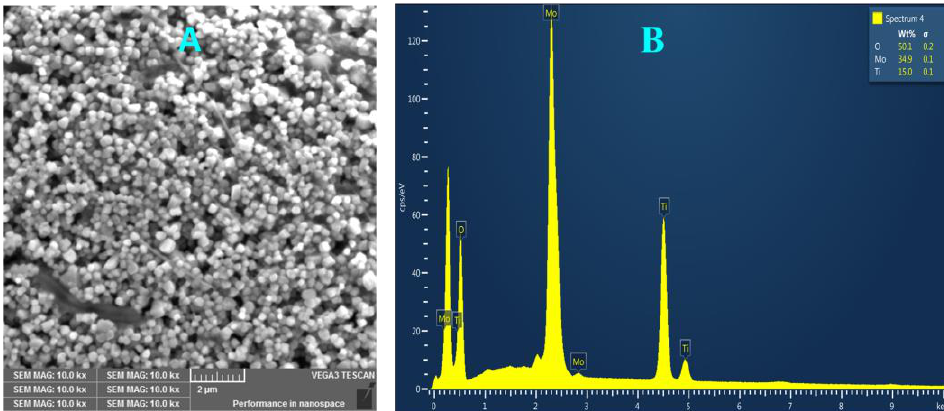
Figure 1. ( A ) SEM image of Ti-Mo NC and ( B ) a representative EDX spectrum obtained from individual particles.